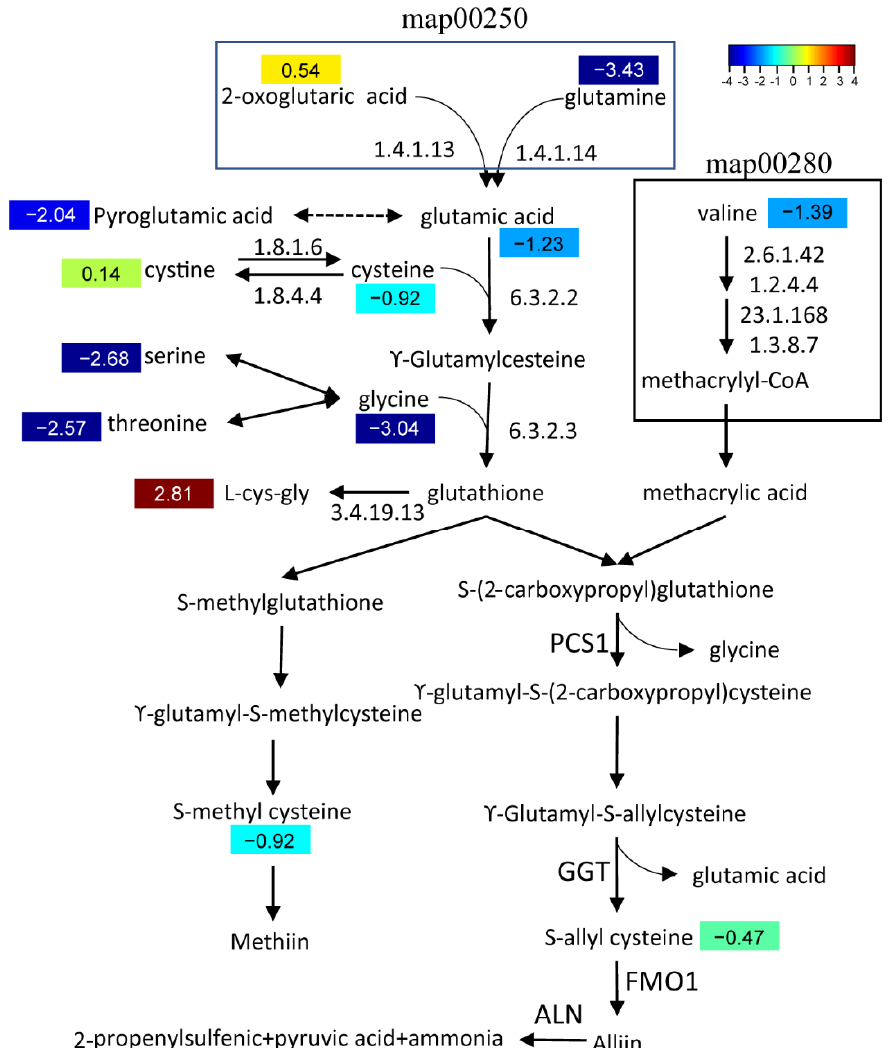
Figure 6. Biosynthetic pathway of a garlic odor compound. Pathways of valine, leucine, and isoleucine degradation (ko00280); alanine, aspartate, and glutamate metabolism (ko00250); cysteine and methionine metabolism (ko00270); and glutathione metabolism (ko00480) were involved in this pathway. Numbers in color indicate a heatmap of log2 (fold change). Fold change, change in A. tuberosum relative to A. hookeri .